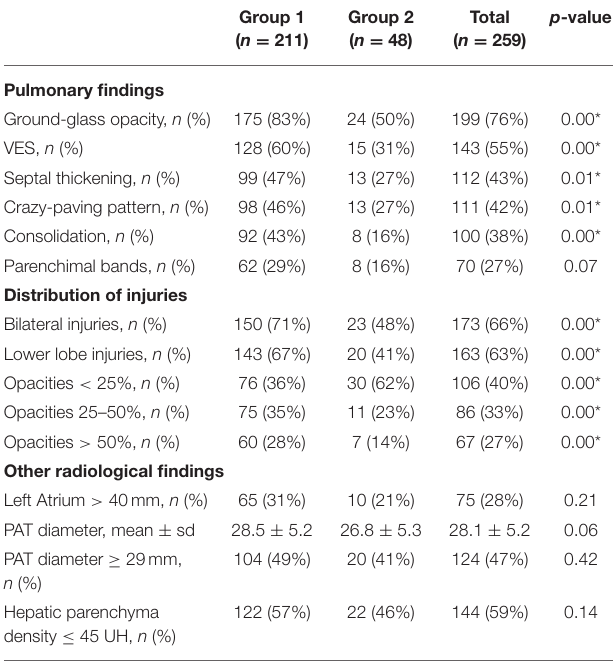
TABLE 2 | Epidemiological, clinical, and laboratorial characteristics of study participants (Belém, Pará, Brazil, 2020).